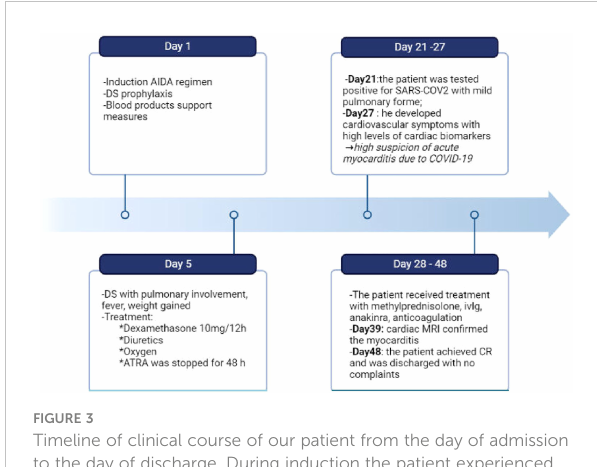
FIGURE 3 Timeline of clinical course of our patient from the day of admission to the day of discharge. During induction the patient experienced differentiation syndrome and covid-19 myocarditis, which required complex therapeutic approaches. DS, differentation syndrome; ivIg, intravenous immunoglobulin; CR, complete remission. Created with